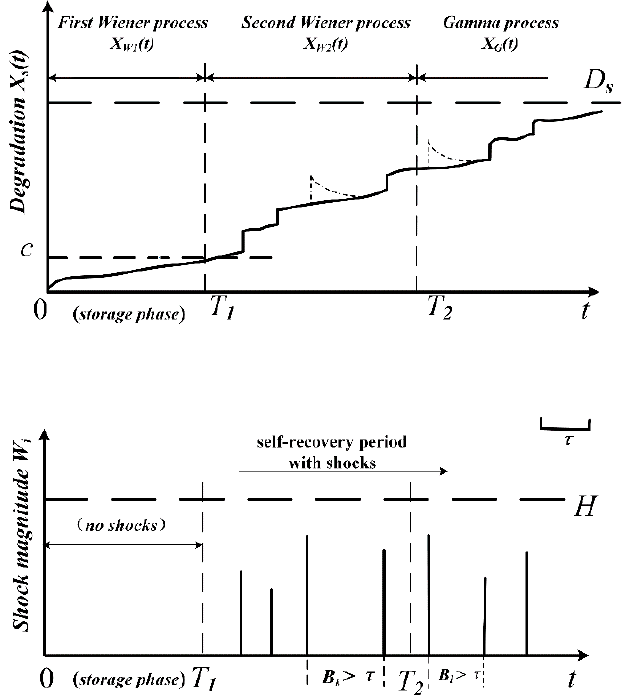
Figure 1. Dependent competing failure processes of a product.